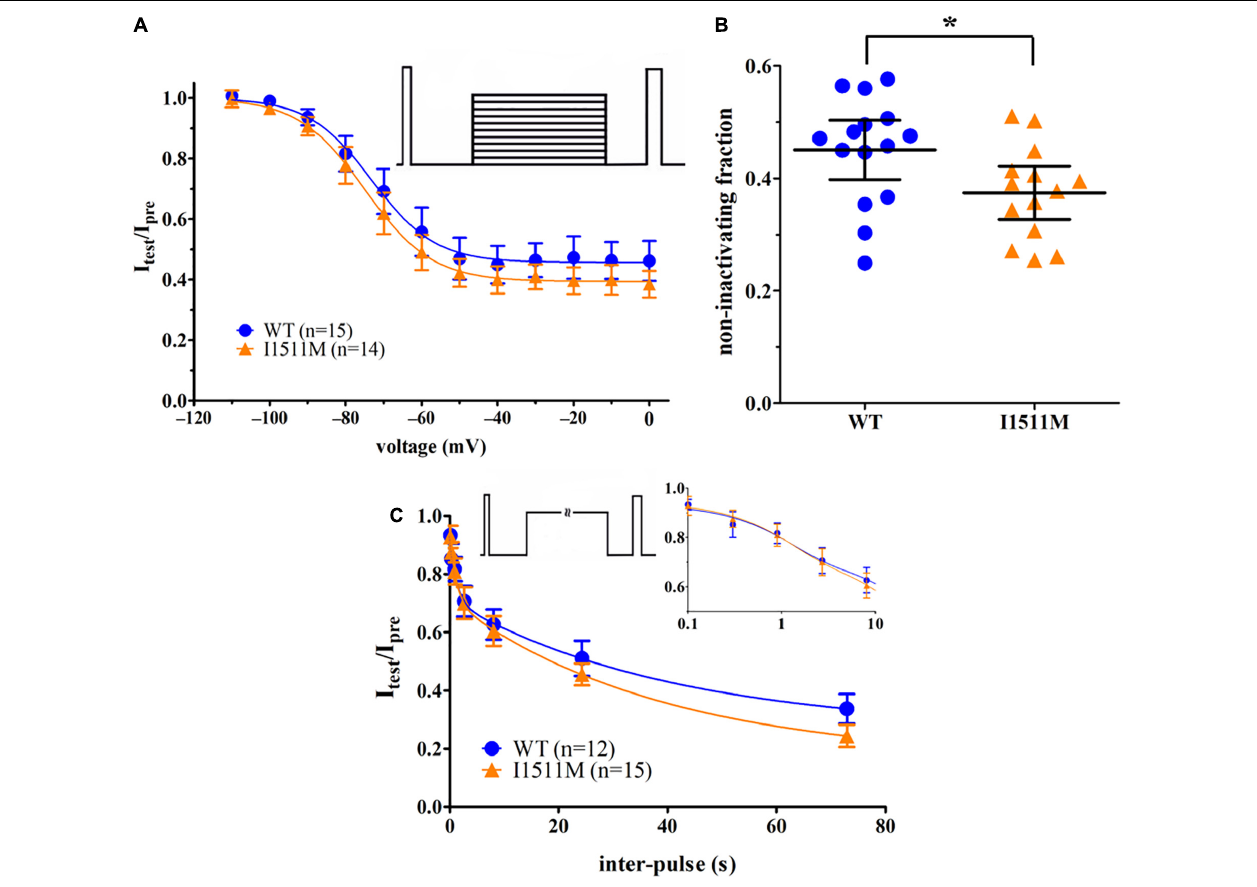
FIGURE 6 | The I1511M mutation shows an enhanced slow inactivation compared to WT channels. (A) Voltage dependence of slow inactivation for hNa v 1.8 WT and I1511M. The voltage protocol is shown as inset. (B) Comparison of the non-inactivating fraction of the Boltzmann fit shown in panel (A) for each cell. (C) Onset of slow inactivation. The plot displays the development of current ratio I test /I pre over the different inter-pulse durations. Magnification of shorter inter-pulse durations on a logarithmic x-axis as well as the voltage protocol are shown as inset. * p <